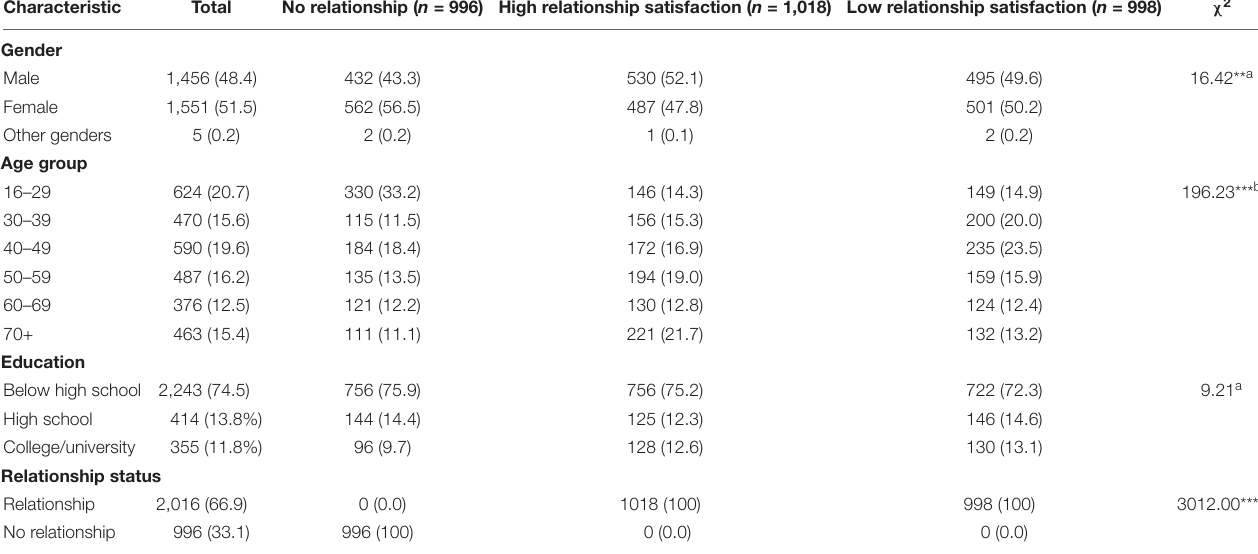
TABLE 1 | Overview of socio-demographic characteristics of all participants ( n = 3,012).